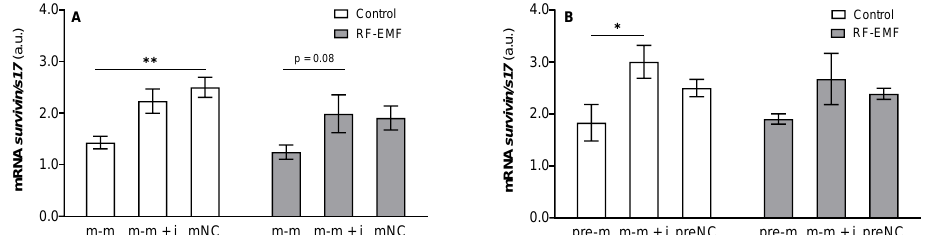
Figure 8. Effect of miR-34a administration on survivin mRNA expression in DLD1 cells under control and RF-EMF conditions. Cells were transfected with ( A ) miR-34a-5p (m-m), ( B ) pre-miR-34a (pre-m), mimic of mature miR-34a together with the miR-34a inhibitor (m-m + i) or corresponding negative control of mature and pre-miRNA (mNC and preNC, respectively). The data were relativised to the corresponding negative control measured under control conditions and presented as the mean ± SEM (n = 4). a.u. — arbitrary units. Two-way ANOVA, Tukey ’ s post hoc test, * p < 0.05, ** p < 0.01.